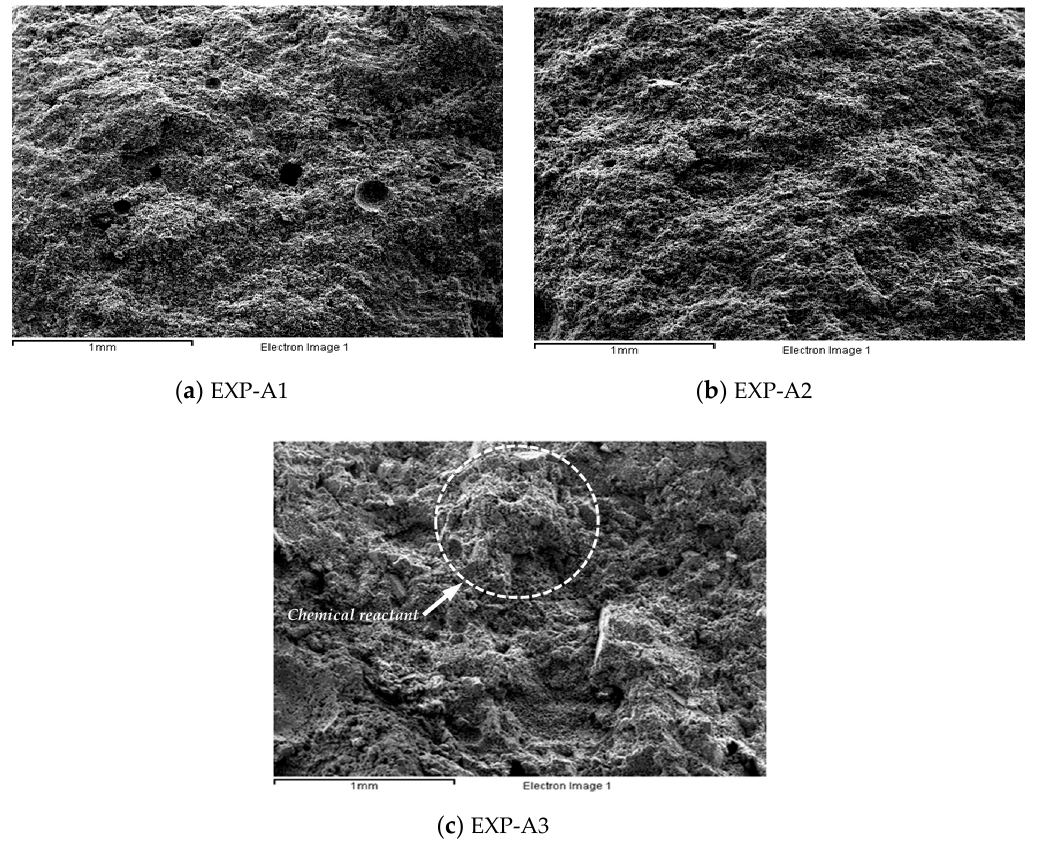
Figure 9. SEM image of specimens. ( a ) EXP-A1, ( b ) EXP-A2, and ( c ) EXP-A3.